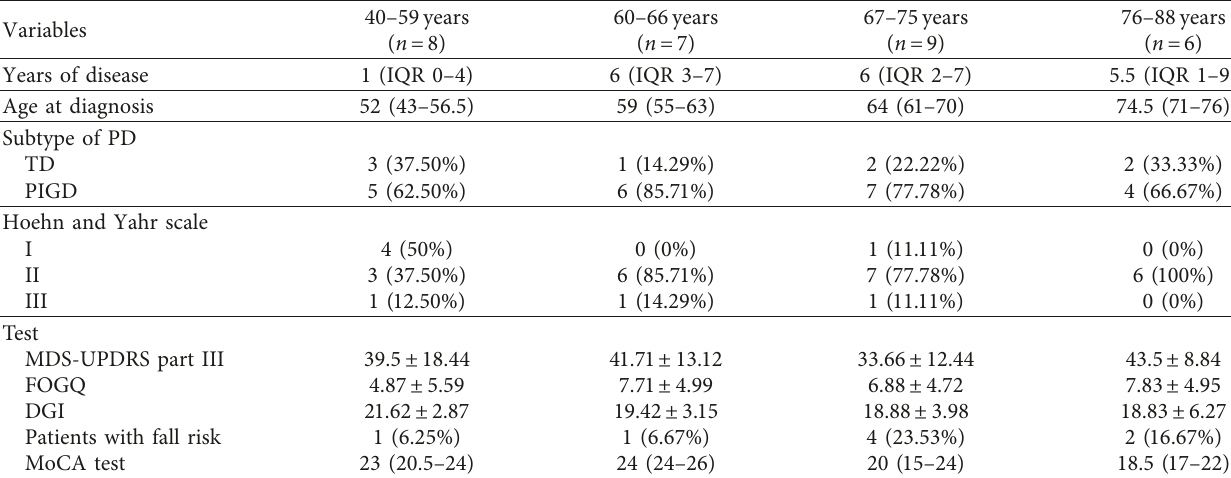
Table 2: PD patient characteristics by age group.